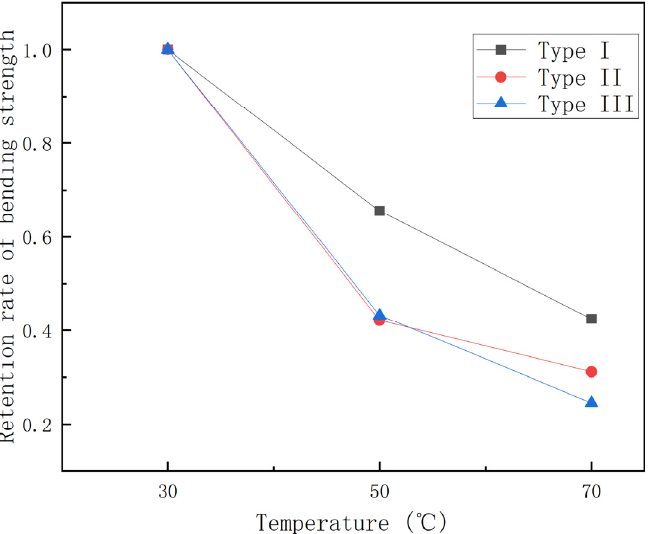
Figure 8. Bending strength retention–temperature curve.